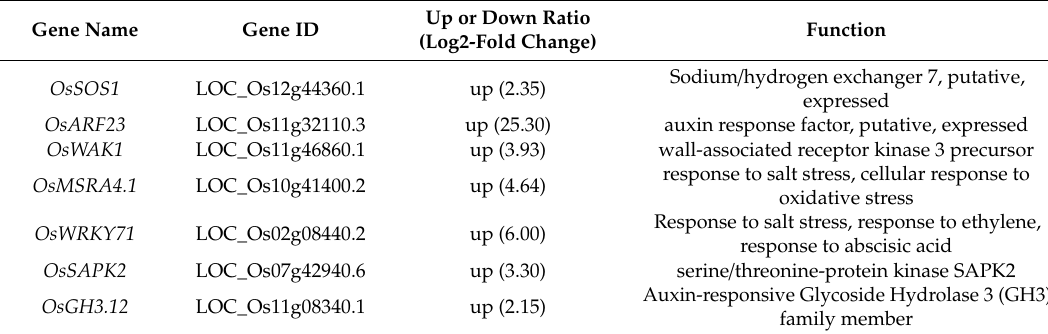
Table 1. List of candidate genes for salt stress tolerance among the di ff erentially expressed genes detected by